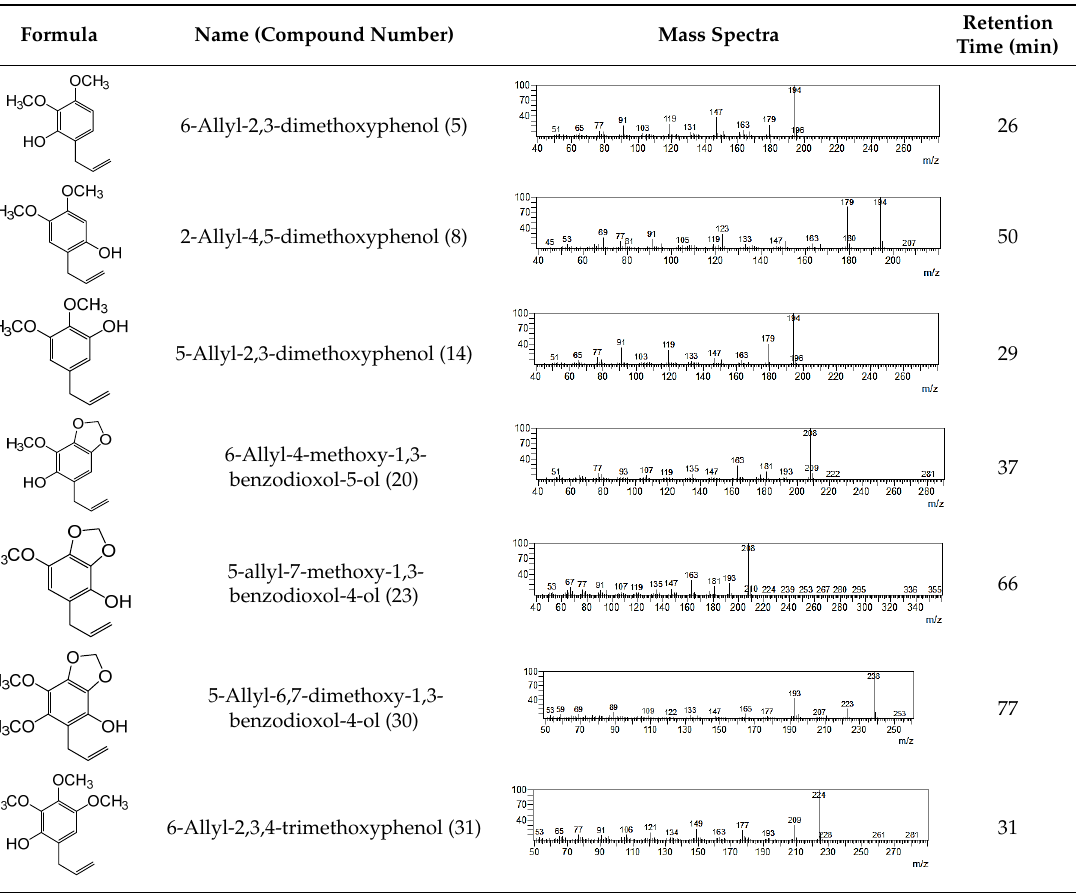
Table 2. Synthesized allylphenols used in this study.